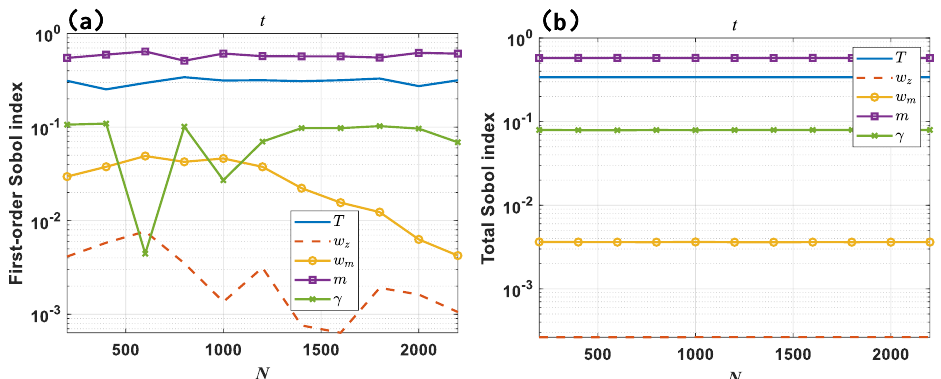
Figure 10. ( a ) Five atmospheric parameters’ first-order Sobol index convergence lines for the infra- sound propagation travel time t in a phase loop; ( b ) Five atmospheric parameters’ total Sobol index convergence lines for the infrasound propagation travel time t in a phase loop (the blue, dark red, yellow, purple, and light green curves indicate temperature T , zonal wind w z , meridional wind w m , mean atmospheric molar mass m , and specific heat ratio γ , respectively).